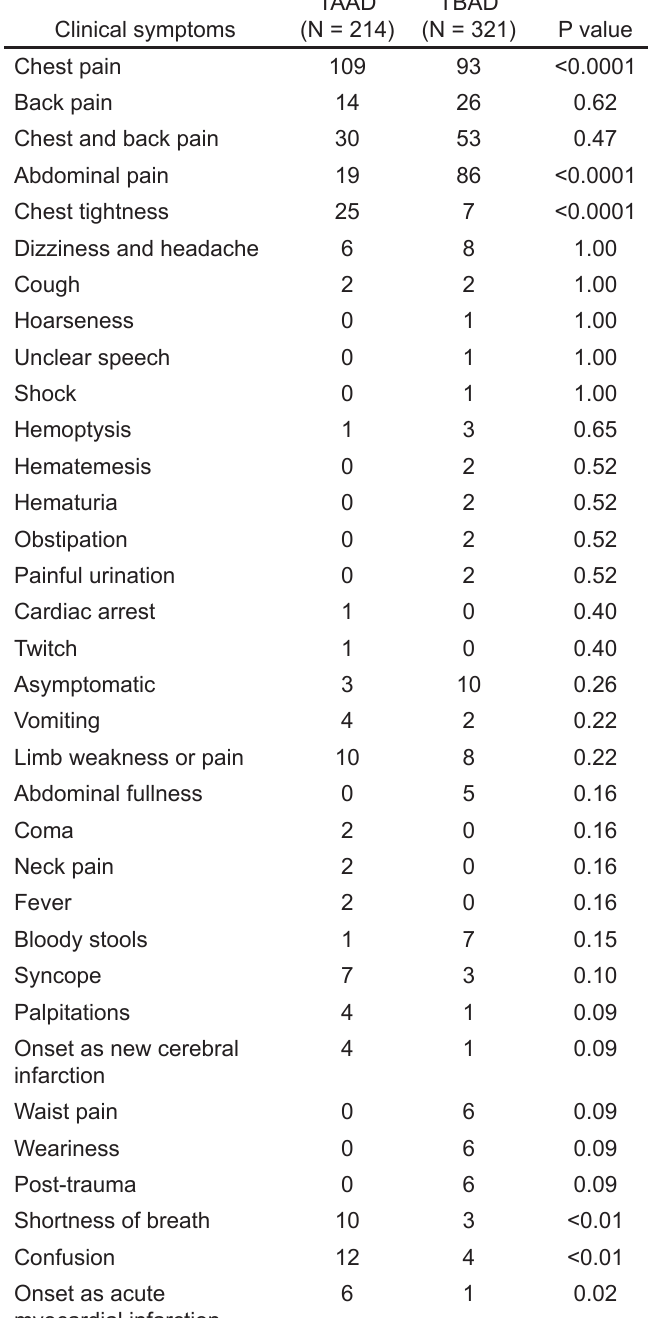
Table 3. Patients’ istories. Table 4. Signs and symptoms in aortic dissection